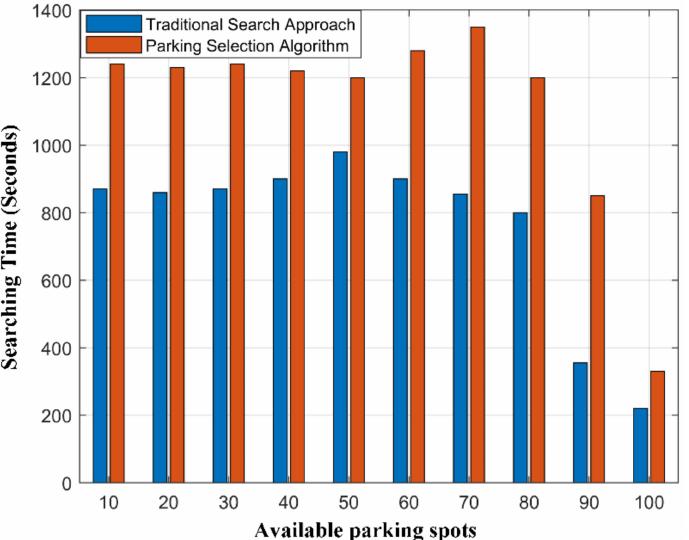
Figure 10. Searching time with different available parking spots using parking selection algorithm and traditional search approach.